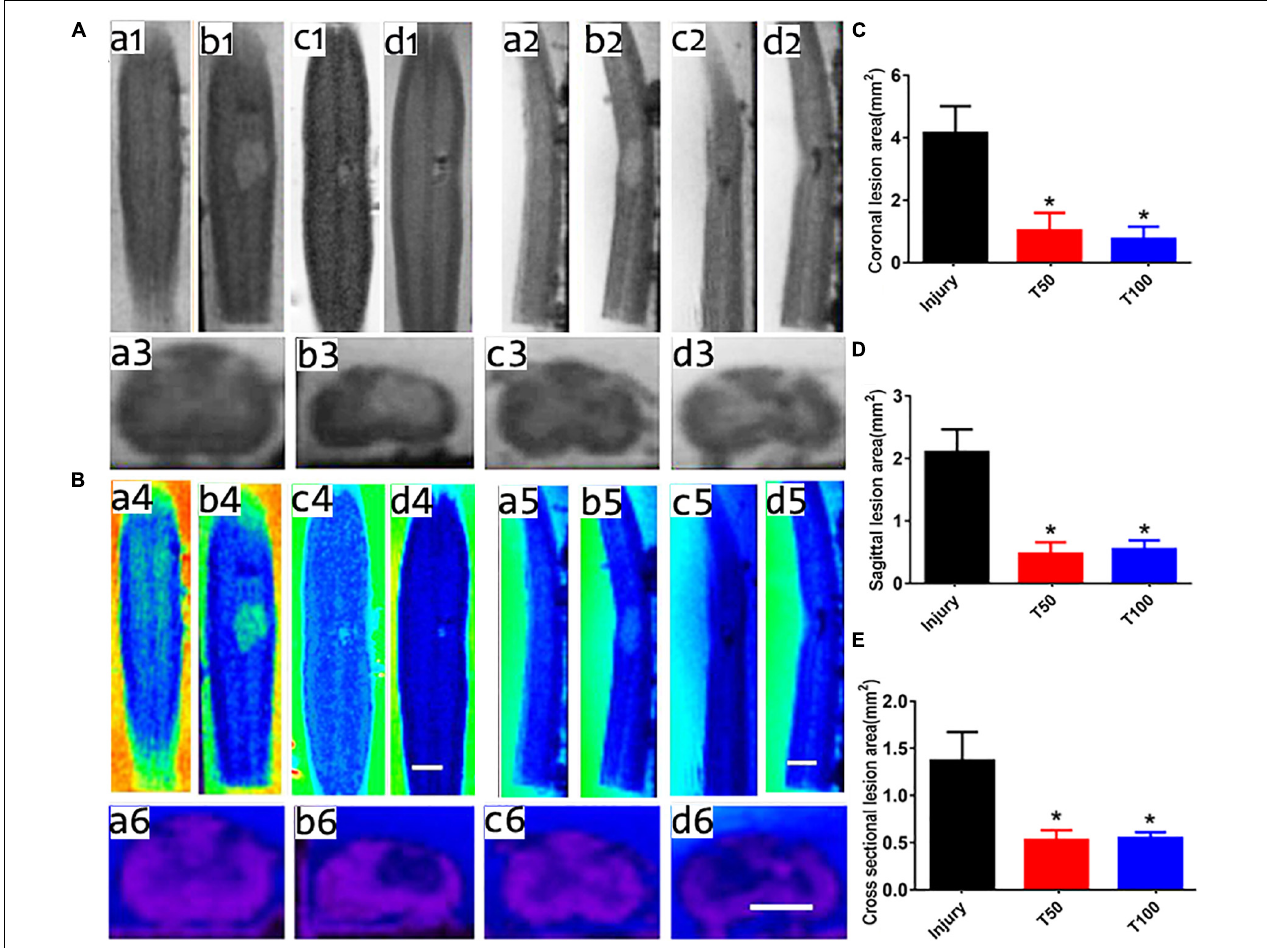
FIGURE 6 | MRI scanning results. (A) (a1–d1) Coronal plane scanning for Sham group, injury group, T50 group and T100 group; (A) (a2–d2) sagittal plane scanning for Sham group, injury group, T50 group and T100 group; (A) (a3–d3) cross-sectional plane scanning for Sham group, injury group, T50 group and T100 group; (B) (a4–d4) color NIH coronal images for Sham group, injury group, T50 group and T100 group; (B) (a5–d5) color NIH sagittal images for Sham group, injury group, T50 group and T100 group; (B) (a6–d6) color NIH cross-sectional images for the Sham group, injury group, T50 group and T100 group; (C) lesions area of coronal plane; (D) lesions area of sagittal plane; (E) lesions area of cross-sectional plane. * P < 0.05, comparison between T50 group or T100 group and injury group. Scale bar = 2